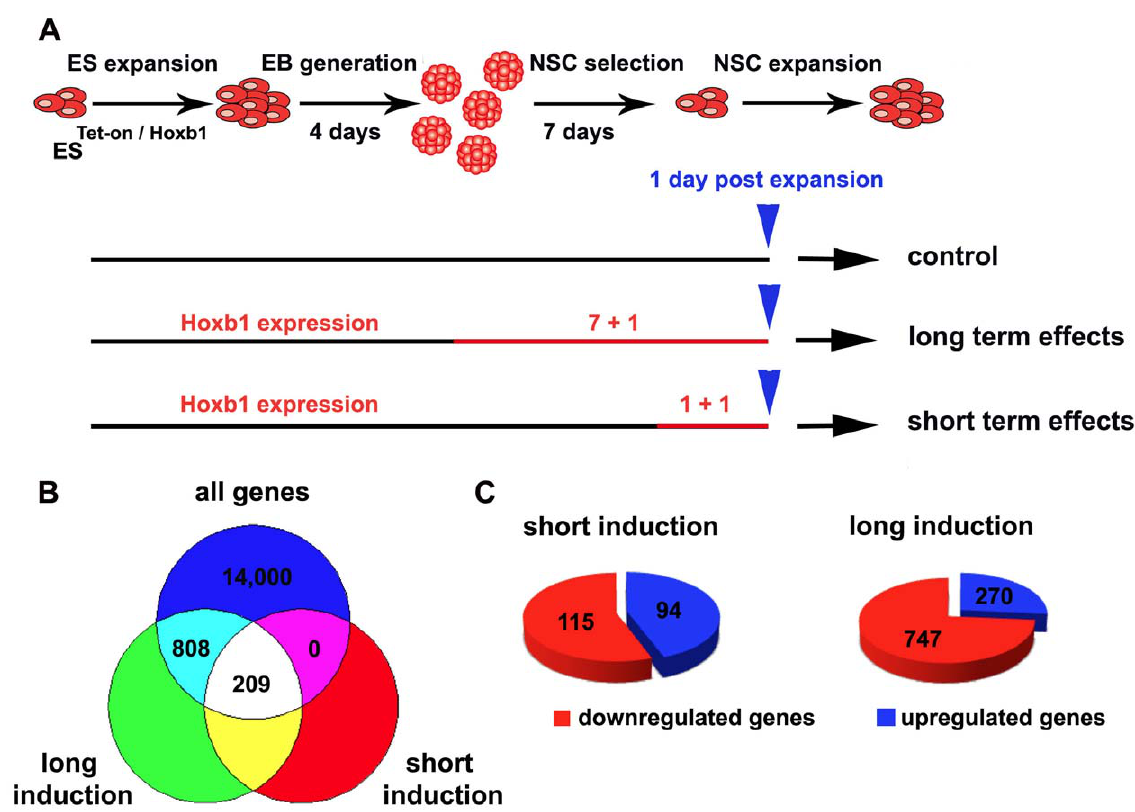
Figure 1. ES differentiation and Hoxb1 induction scheme, comparison of gene expression profiling results. (A) Graphic representation of ES Tet-On/Hoxb1 cell differentiation towards neural stem cells (NSCs) for the identification of Hoxb1 target genes. The induction length is shown in red (days) and blue arrows indicate the time point of microarray gene expression analysis. (B) Venn diagram of genes differentially regulated in the long and short Hoxb1 induction schemes. (C) Pie charts of up and down regulated genes in the two induction schemes. Alexa 568 (Molecular Probes) used at 1:500. Images were acquired using a Leica TCS SP5 confocal microscope.